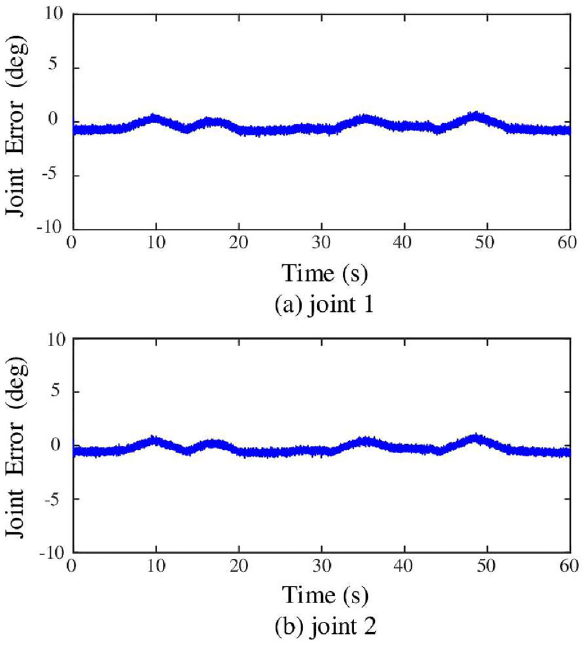
Fig. 12 Joint position error under proposed decentralized robust inter- action control method ized integral sliding model control method as well as the proposed control method. Since the experimental platform is assembled in parallel by a 2-DOF robot, since the contact force of the end-effector along the Z-axis has no compo- nent, the trajectory of the end effector is two dimensional. The assignment of human–robot interaction contact force of